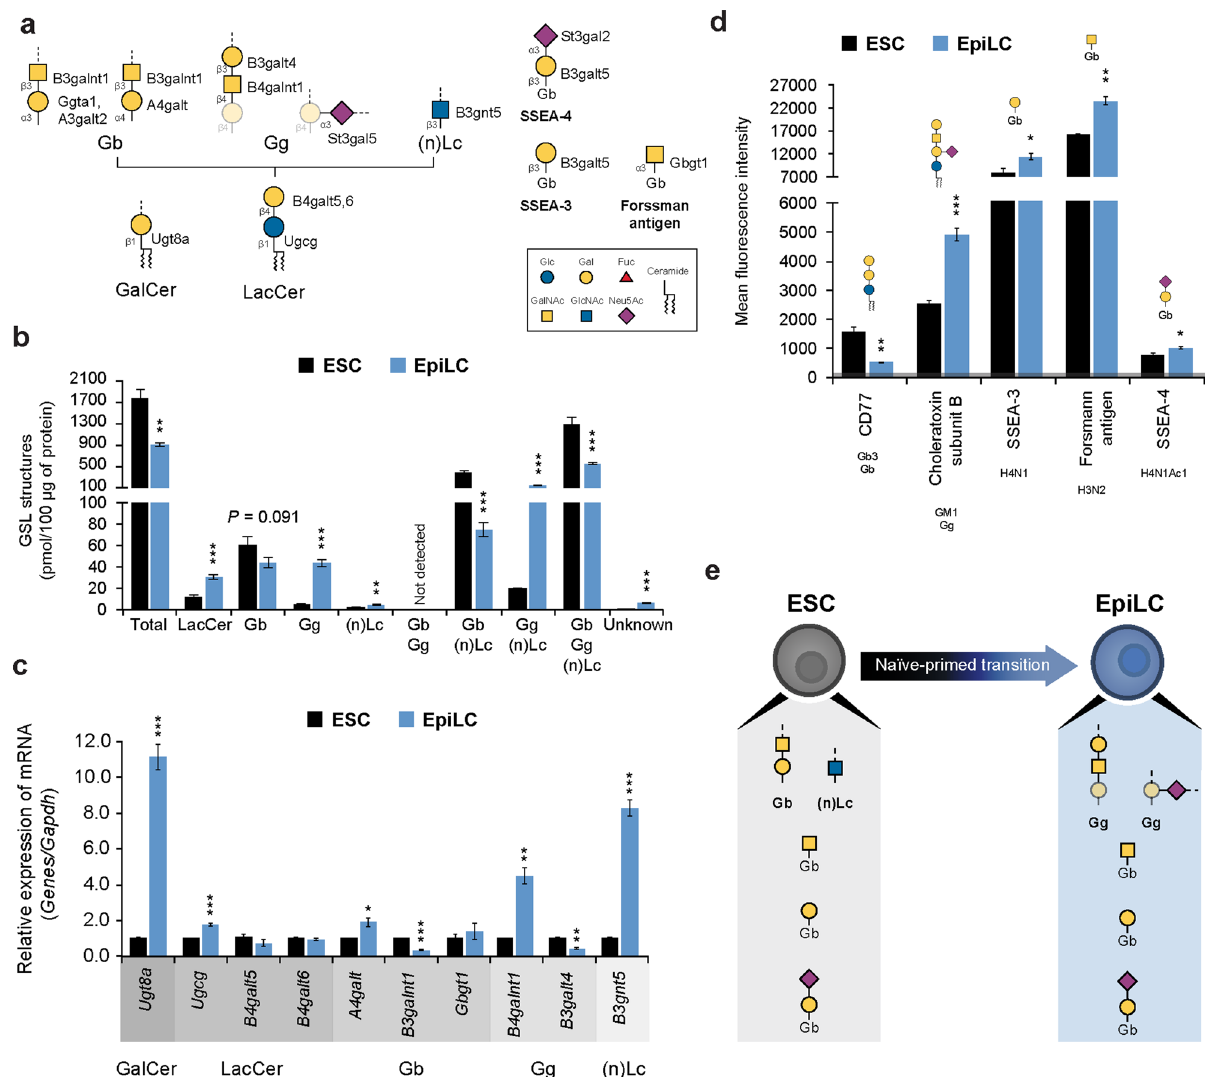
Figure 5. GSL structural and transcriptional analysis in ESCs and EpiLCs. ( a ) Schematic diagram of the GSL synthetic pathway. ( b ) Absolute amount of GSL detected by MS in ESCs and EpiLCs. GSL subclasses: galactosylceramide (GalCer), lactosylceramide (LacCer), globo (Gb), ganglio (Gg) and neolacto/lacto ((n) Lc). The GbGg, Gb(n)Lc, Gg(n)Lc, and GbGg(n)Lc histograms represent GSL structures which, based on the deduced composition by MS, cannot be categorize in a single subclass. ( c ) Real-time PCR analysis of GSL- specific enzymes normalized against Gapdh in ESCs and EpiLCs, and shown as a fold change relative to ESCs. ( d ) GSL structure profiling by FACS using specific Abs in ESCs and EpiLCs. Ab specificities are stated below the labels and schematically represented above each histogram. The grey line at the bottom represents the negative control staining. ( e ) Model of GSL modifications during ESC to EpiLC transition. Values are shown as means ± s.e.m. of three independent experiments ( c , d ) and four independent experiments in ( b ). Significant values are indicated as * P < 0.05, ** P < 0.01, and *** P < and Forssman antigen staining mildly increased in EpiLCs (Fig. 5d and Supplementary Fig. S9). However, it is worth noting that SSEA-3,4 and Forssman antigen are structures of the Gb series (Fig. 5a), which we showed to be dramatically reduced and undergo a switch to Gg series upon ESC differentiation to EpiLCs, thus suggesting that Gg series structures might be more suitable differentiation markers. Together, these data show that the GSL composition shifts from Gb and (n)Lc to Gg series during ESC to EpiLC transition, and demonstrate the pres- ence of SSEA-3,4 and Forsmann antigen structures in both ESCs and EpiLCs (Fig. 5e). Elongation/branching and capping/terminal modifications. Glycosylation is a stepwise process involving more than 200 distinct glycosyltransferases and related enzymes in mammals. These can be classified as pathway-specific and pathway-non-specific, which generally include enzymes involved in biosynthetic steps overlapping different glycosylation classes, such as elongation/branching and capping/terminal modifications (Fig. 6a). Transcriptional analysis by Real-time PCR showed that B3galt1,2,5 and B4galt2-4, involved in type I